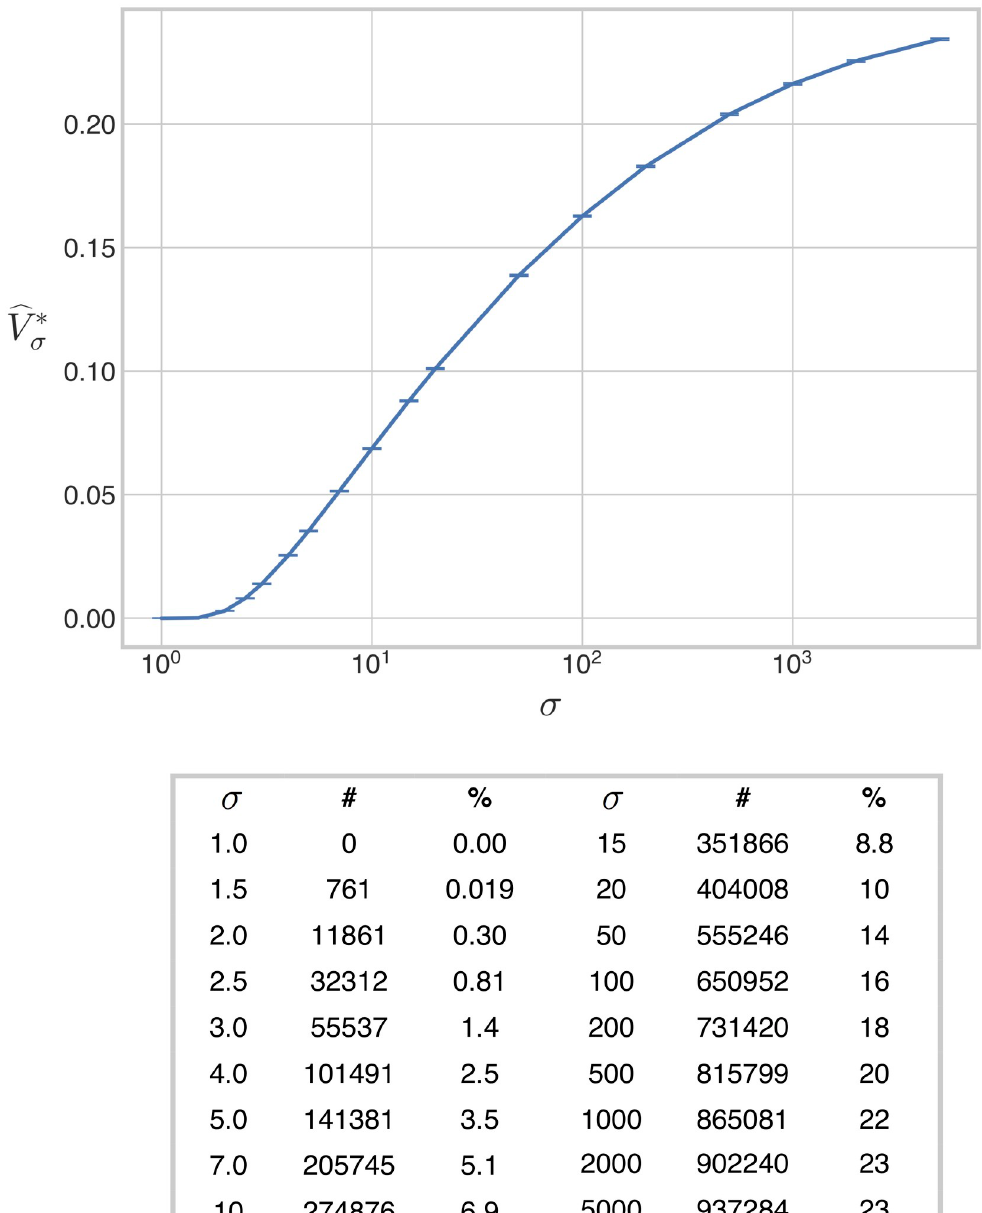
Fig 6. Volume of the bistable region under strong irreversibility. The 6-dimensional volume of the bistable region, normalised as a proportion of the volume of the box H � , is plotted against the values of σ in Eq 11, along with the additional values σ = 1000, 2000, 5000, for the case when the reactions S table lists the number of bistable points found for each value of σ , together with the percentage of the box H � occupied by the bistable region. The error bars give 95% confidence intervals for each estimate (Materials and methods). The estimates have been joined by line segments.